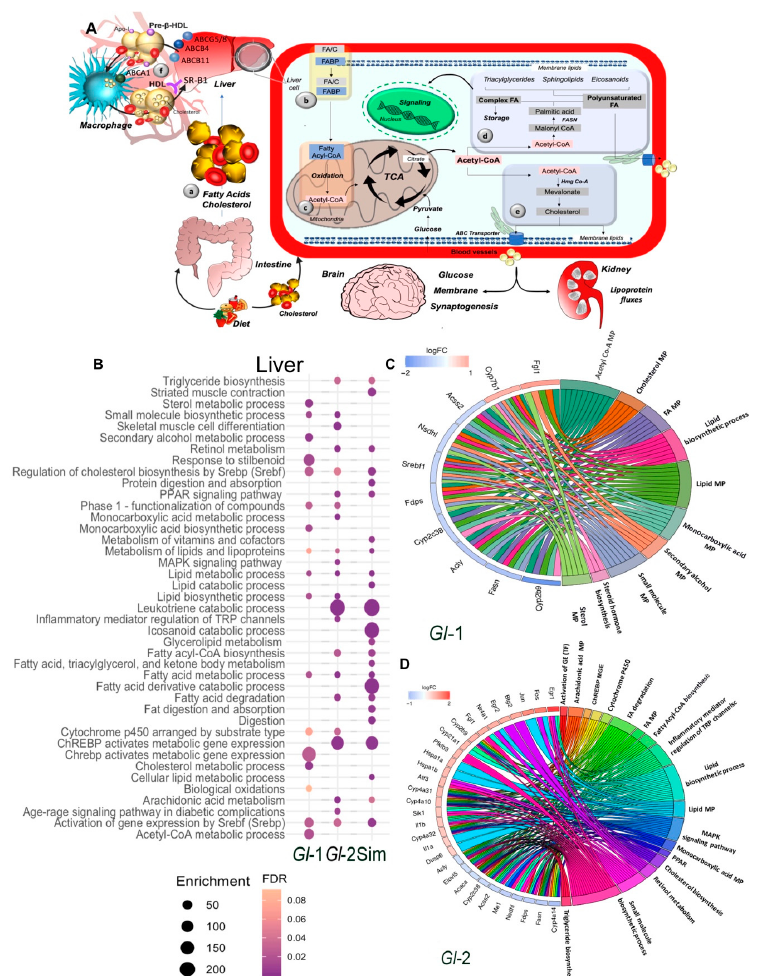
Figure 1. Main pathways of lipid metabolism altered by a high-cholesterol diet (HCD) given to C57BL/6 mice, including the administration of standardized hydroalcoholic extracts ( Gl -1, Gl -2) from a Mexican strain of Ganoderma lucidum , in comparison with the drug simvastatin. ( A ) Schematic overview of major pathways involved in lipid metabolism. (a) Fatty acids (FAs) from dietary ingestion are either internalized in the cell from blood circulation by fatty acid-binding proteins (FABPs), or synthesized de novo within cells (b). (c,d) De novo lipogenesis begins with the conversion of acetyl-CoA to malonyl-CoA. The multifunctional enzyme fatty acid synthase (FASN) is then coupled to acetyl-CoA and malonyl-CoA to generate palmitic acid, which is further elongated and desaturated to produce diverse saturated and unsaturated FAs (d). These FAs can then be converted to diverse types of lipids, such as diacylglycerides and triacylglycerides via the glycerol phosphate pathway, as well as sphingolipids, phosphoinositides and eicosanoids, which have important signaling functions in cells and tissues. Another class of lipids are sterols, mainly cholesterol (e). (f) Macrophage reverse cholesterol transport. Liver and intestine synthesize apolipoprotein A-I (Apo-I) that load cholesterol in free pre- β -HDL molecules from peripheral tissues via macrophages ABCA1 transporter. These HDL complex particles mature and transport its cholesterol directly to the liver via the hepatic scavenger receptor class B type 1 (SR-B1) receptor. At systemic level, major organs involved in lipid metabolism are liver, skeletal muscle, and adipose tissue, which express specific receptors and transport proteins for lipids uptake. However, other organs are also involved, such as brain and kidney, which contribute in lipoprotein fluxes and lipid metabolism. TCA: tricarboxylic acid cycle. C: cholesterol. ( B ) Pathway enrichment analysis, represented in a bubble plot, of hepatic differentially expressed genes in mice liver fed with a HCD, treated with Gl -1 or Gl -2 extracts, or simvastatin. Bubble size represents the enrichment score, while their color represents false discovery rate (FDR) values. Circos plots showing the relationship between selected terms and annotated genes as indicated by connecting lines at Gl -1 ( C ) and Gl -2 ( D ) interventions. Genes are located on the left side of the graph, and ordered on the basis of their logFC values. MP: metabolic